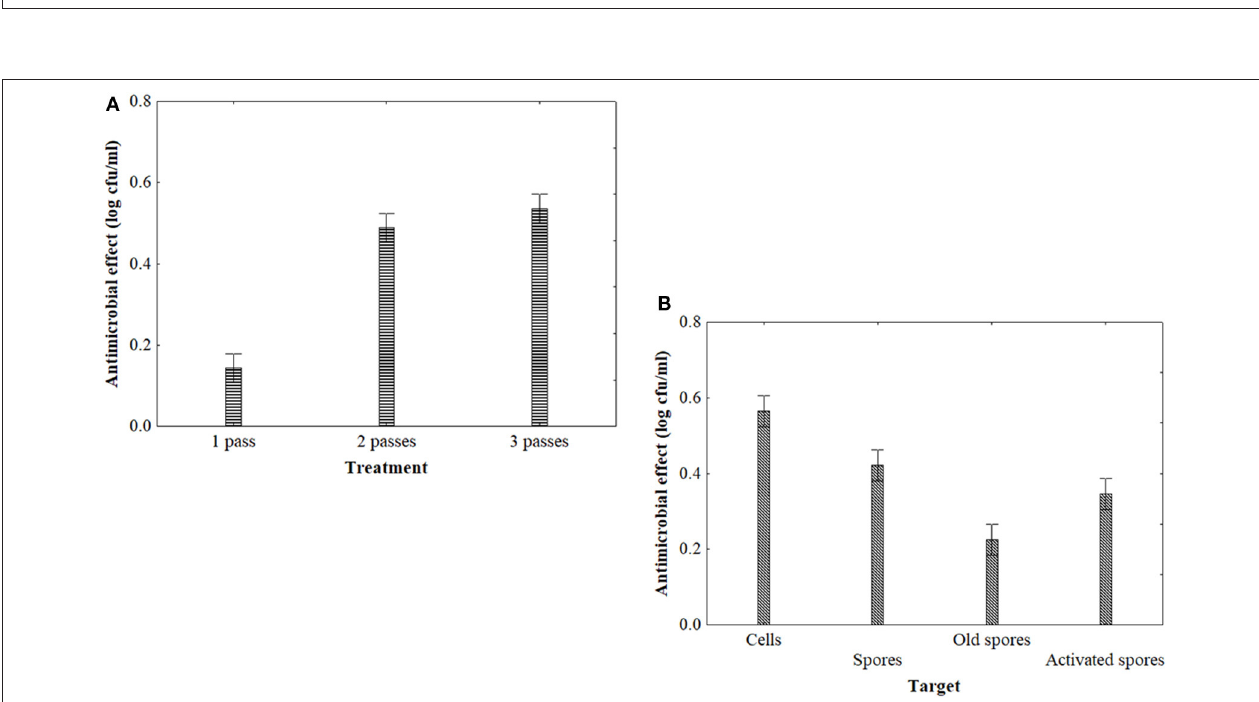
FIGURE 1 | Decomposition of the statistical hypothesis of ANOVA for the effect of compounds (A) , strain (B) , and target (C) on the antimicrobial effect (reduction of viable count, log cfu/ml) of A. acidoterrestris . Vertical bars denote the 95% confidence intervals.